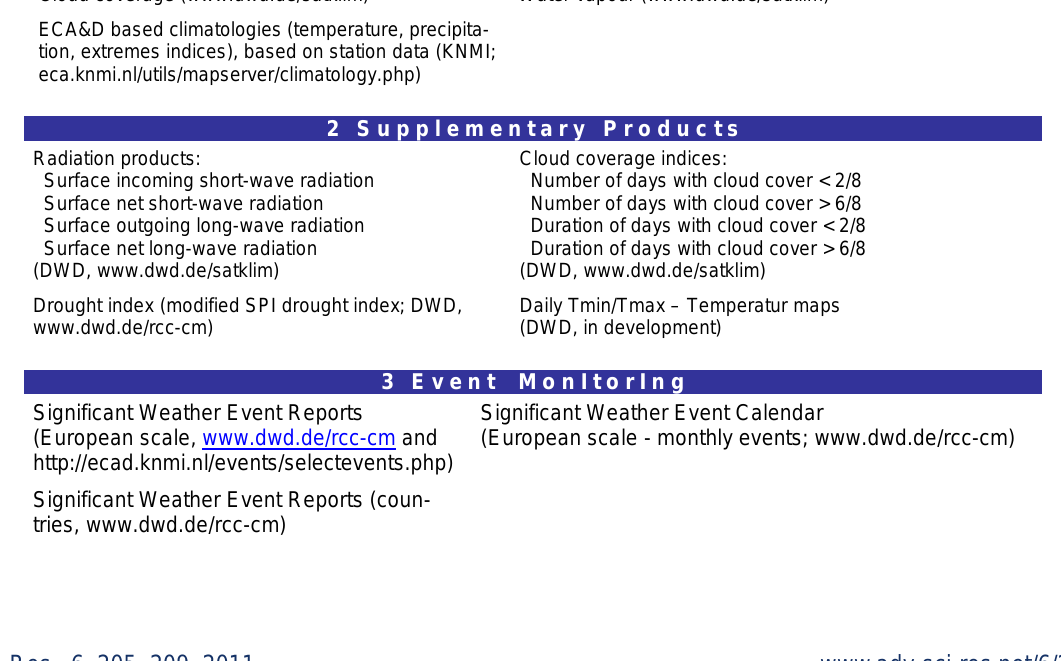
Table 1. RCC-CM Product catalogue, Status of 31 December 2010.